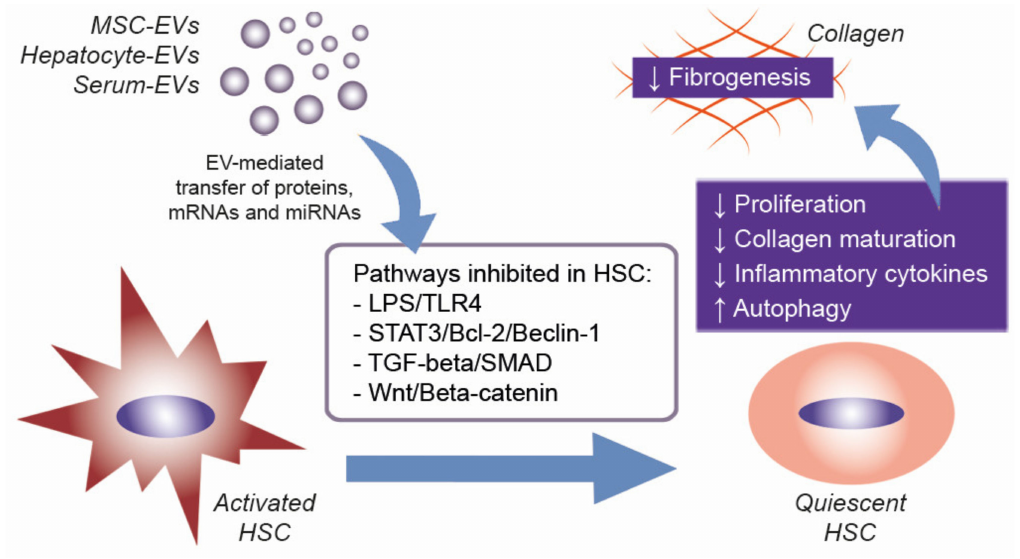
Figure 3. EV e ff ects on HSC during liver fibrosis. EVs derived from di ff erent sources, such as MSCs, hepatocytes, and serum, contain proteins and specific patterns of mRNAs and miRNAs that can modulate a number of molecular pathways in target cells. In liver fibrosis, the possible EV uptake by activated HSC could revert its quiescent state, thus reducing HSC activation and fibrogenesis. TGF, transforming growth factor; TLR4, toll-like receptor 4; SMAD, small mothers against decapentaplegic; STAT, signal transducer and activator of